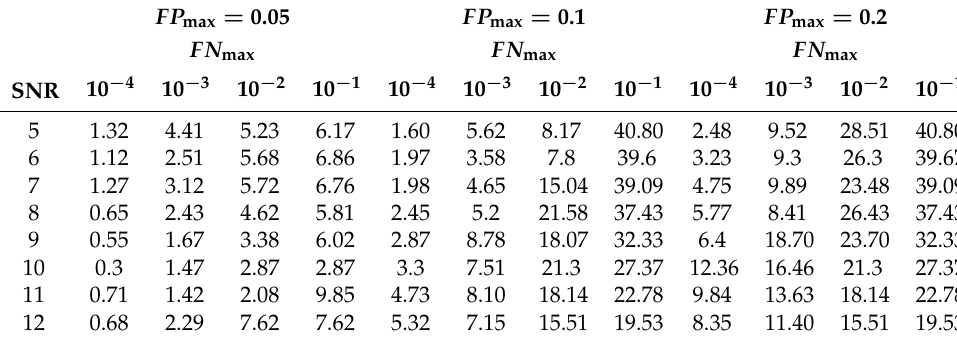
Table 3. Gain in % in terms of a probability of a system being